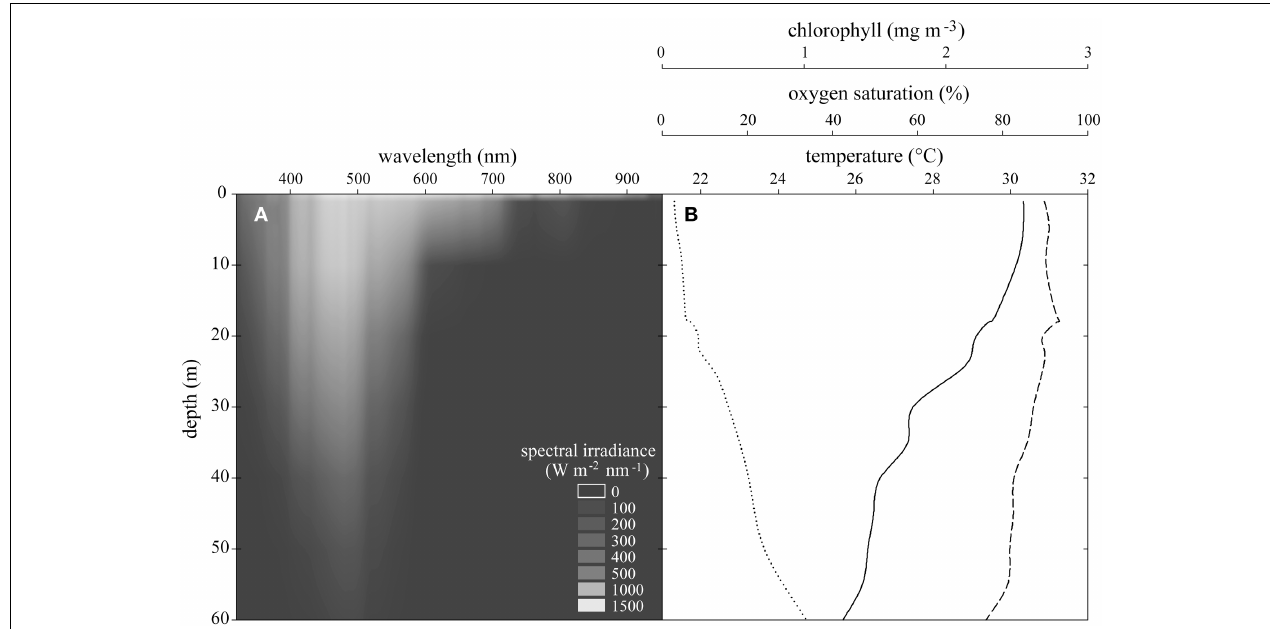
FIGURE 2 | (A) Spectral irradiance at each wavelength over experimental depths. (B) Means of CTD casts of temperature (solid line), oxygen saturation (dashed line), and chlorophyll concentration (dotted line) between 0 and 60m in the Saudi Arabian central Red Sea.